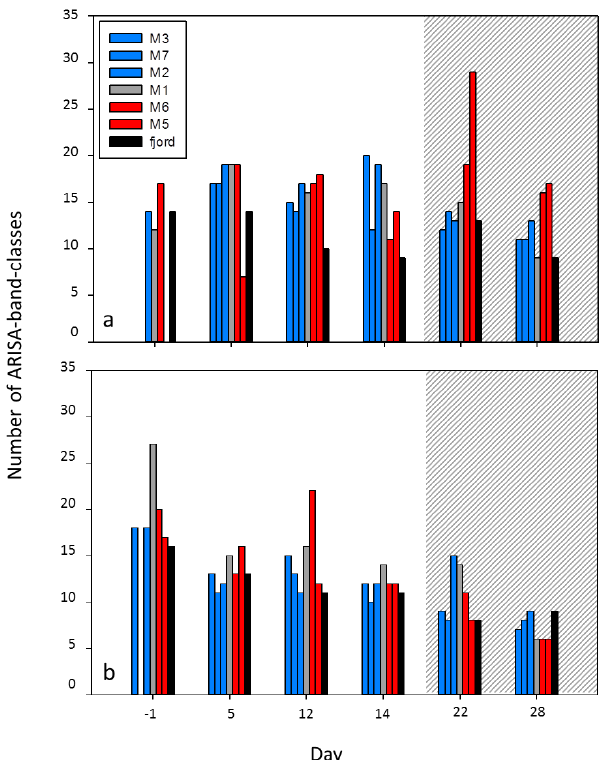
Fig. 3. Development of ARISA band classes in the (a) particle- associated community and (b) free-living community during the experiment. The colours encode treatment level. Blue: low CO 2 = M3, 7 and 2 ( ∼ 175–250µatm average over experiment); grey: medium CO 2 = M1 ( ∼ 600µatm average over experiment); red: high CO 2 = M6 and M5 ( ∼ 675–860µatm average over experi- ment). The shaded area indicates phase 3 of the experiment (shortly after breakdown of picophytoplankton cell